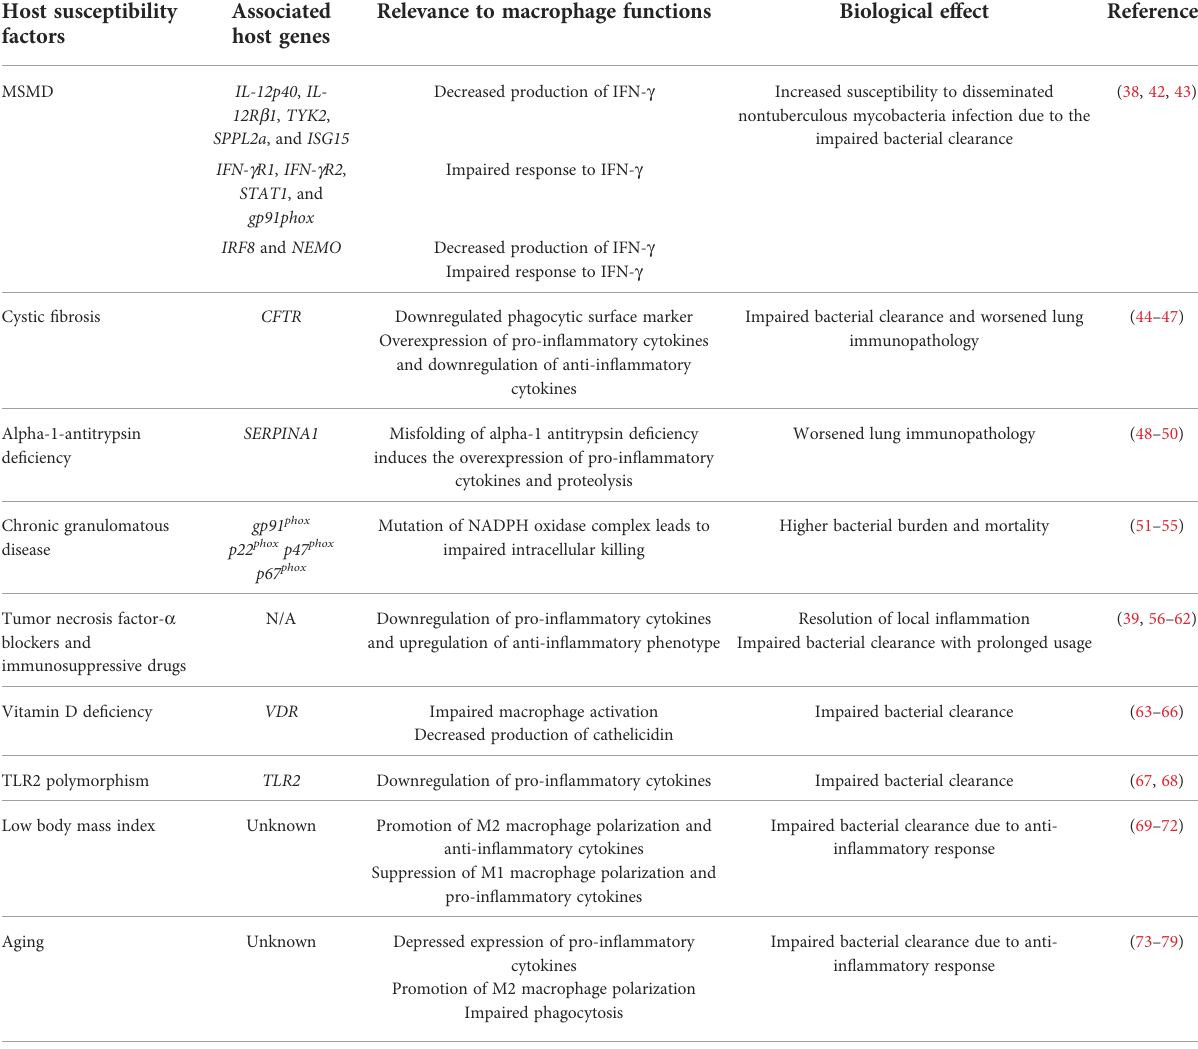
TABLE 1 Primary and acquired host susceptibility factors associated with Mycobacterium avium complex infection and their involvement in macrophage